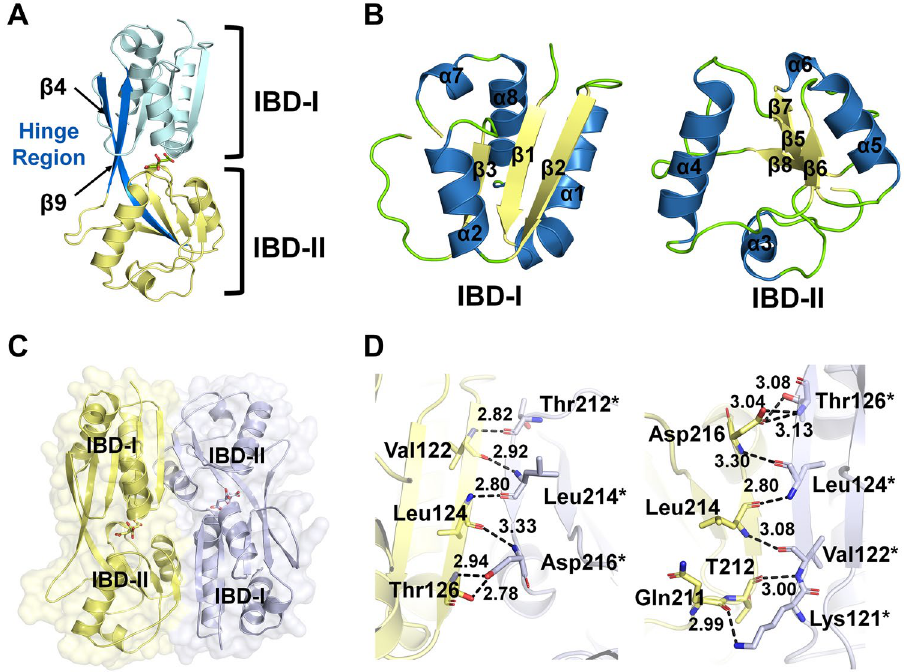
Figure 3. Overall structure of BaCcpC-IBD. ( A ) Monomer structure of BaCcpC-IBD. The hinge regions, consisting of β4- and β9-strands, are indicated in blue. Citrate molecules are located between the IBD-I and IBD-II subdomains. ( B ) Close-up view of the IBD-I and IBD-II subdomains of BaCcpC-IBD. ( C ) Dimer of BaCcpC-IBD. ( D ) Close-up view of the interactions in the dimer interface.